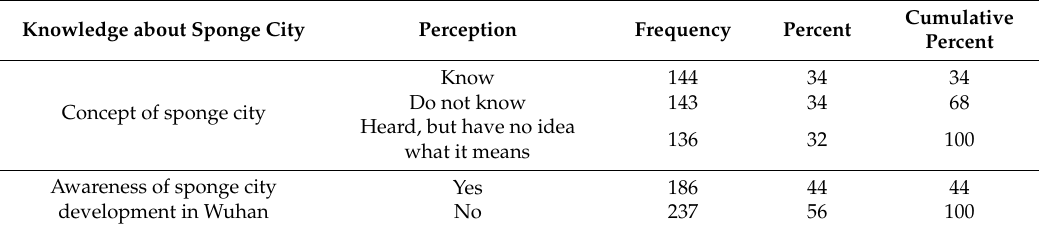
Table 5. Respondents’ perceptions about sponge city.